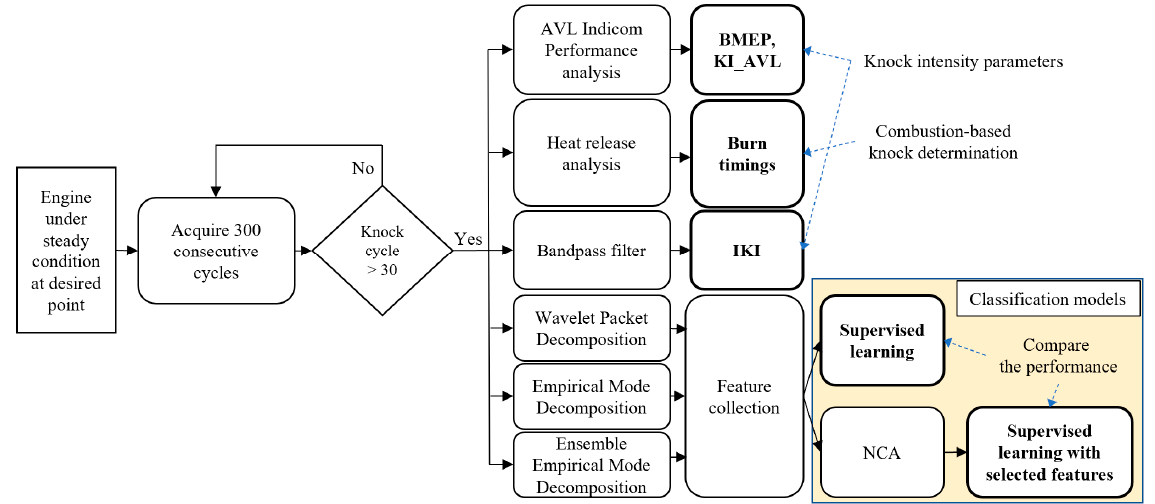
Figure 2. Flow chart of the analysis and modeling procedures.